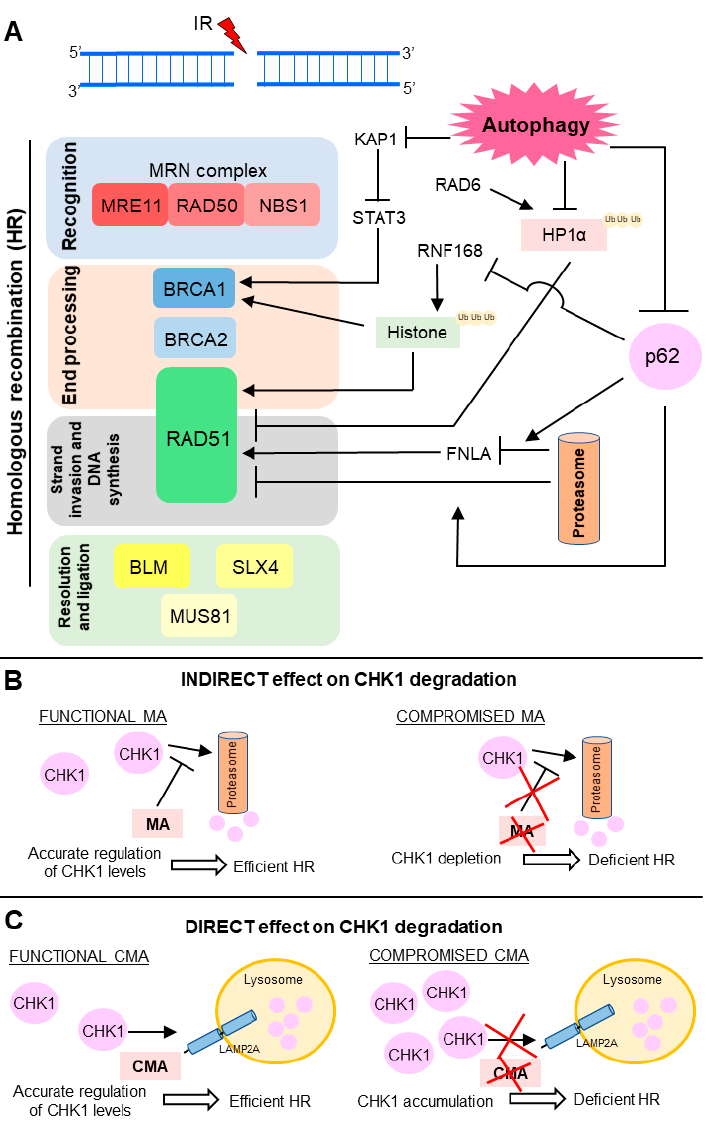
Figure 3. Scheme of the molecular mechanisms known for the autophagy-mediated regulation of double strand break (DSB) repair. ( A ) Main points of the HR modulation by autophagy. Autophagy degrades proteins KAP1 (KRAB (Kruppel-Associated Box Domain)-Associated Protein 1), heterochromatin protein 1 (HP1 α ) and p62) involved in negative modulation of BRCA1 (breast cancer 1) and RAD51, activating HR; ( B , C ) Autophagy controls CHK1 (checkpoint kinase 1) levels through ( B ) indirect and ( C ) direct mechanisms; ( B ) Macroautophagy (MA) down-modulates proteasome- mediated degradation of CHK1. Compromised MA depletes CHK1 levels and decreases HR activity; ( C ) Chaperone-mediated autophagy (CMA) mediates lysosomal degradation of CHK1. CMA deficiency leads to harmful CHK1 accumulation and HR blockage. IR: ionizing radiation.